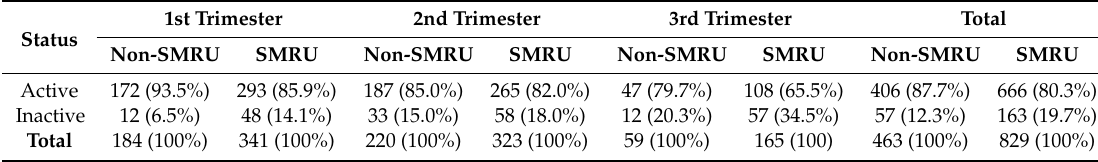
Table 3. Pregnant members enrolled in M-Fund